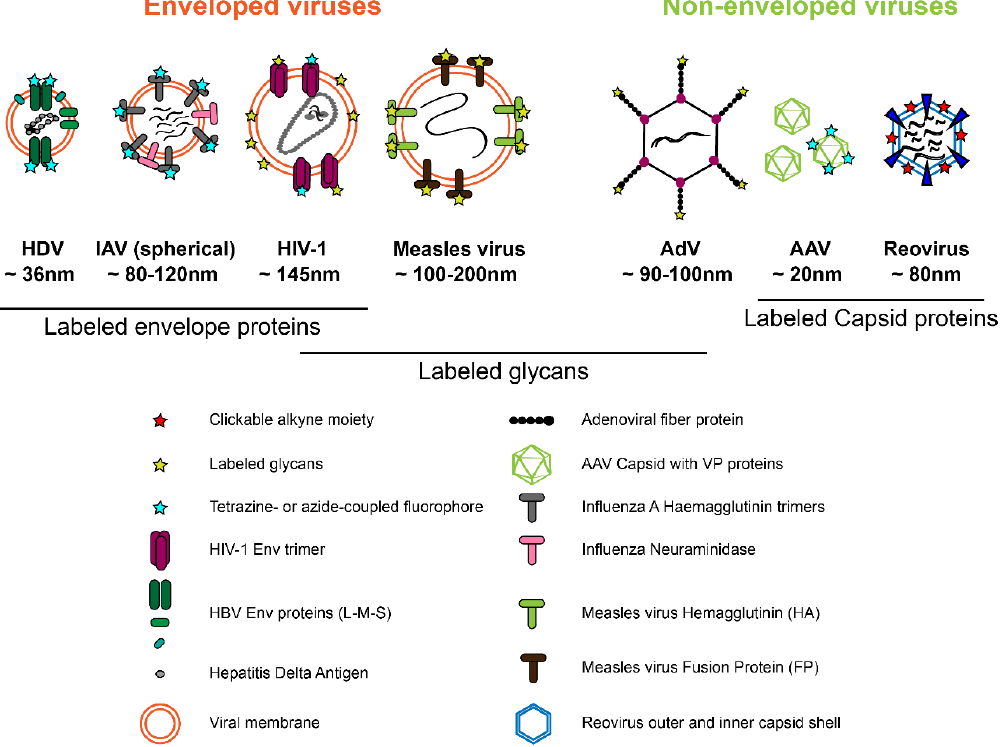
Figure 2. Viral proteins that have been successfully modified by click labeling strategies. See Section 2 for details.